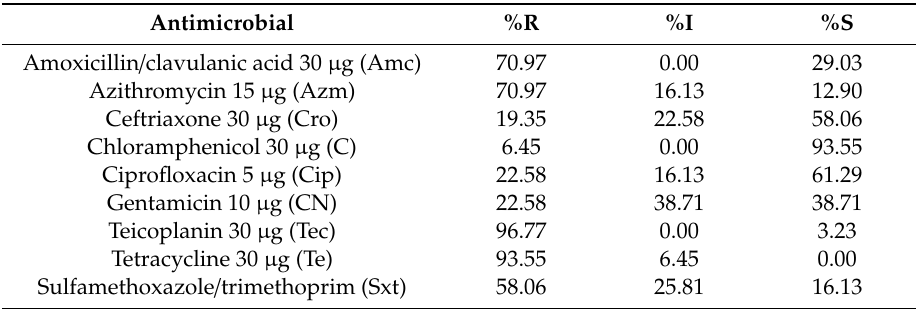
Table 3. Percentage antibiotic resistance of E. coli from ready-to-eat meat samples. Antimicrobial